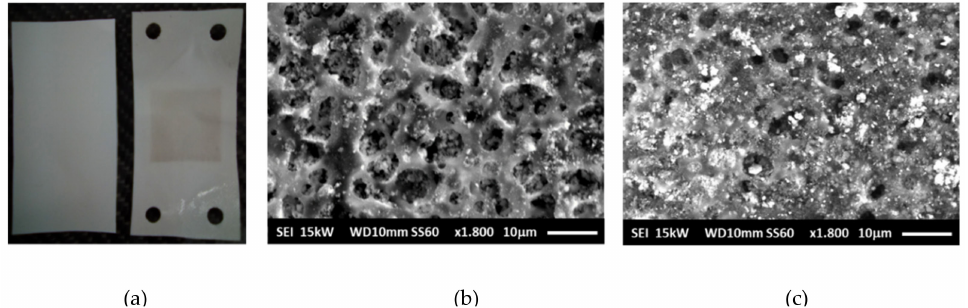
Figure 7. Polarization curves for electrolysis cells at T amb , KOH (30 wt%) for Zirfon ® before and after operating for 130 h (aged sample).